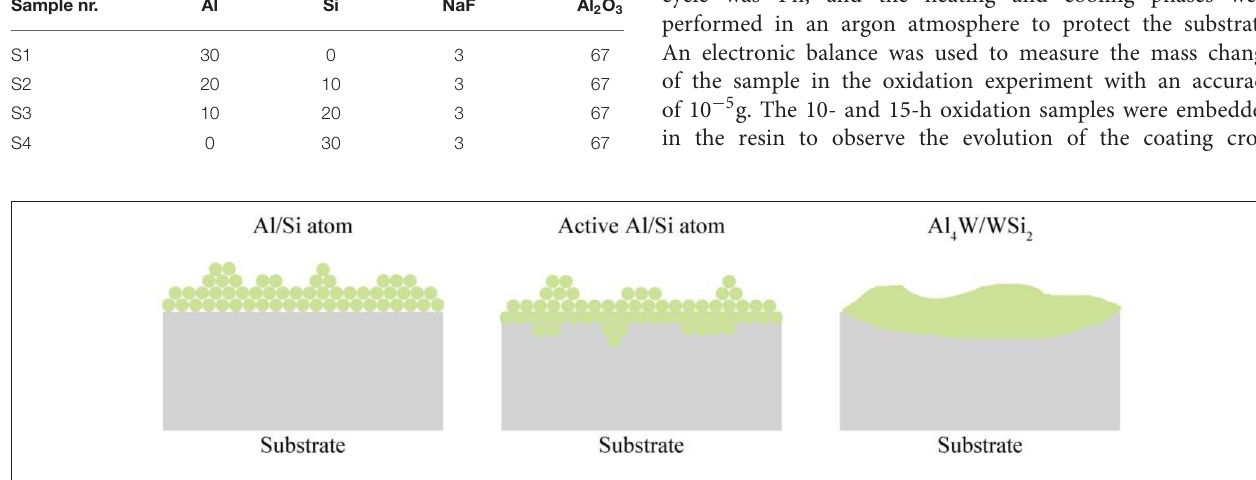
FIGURE 1 | The schematic diagram of pack